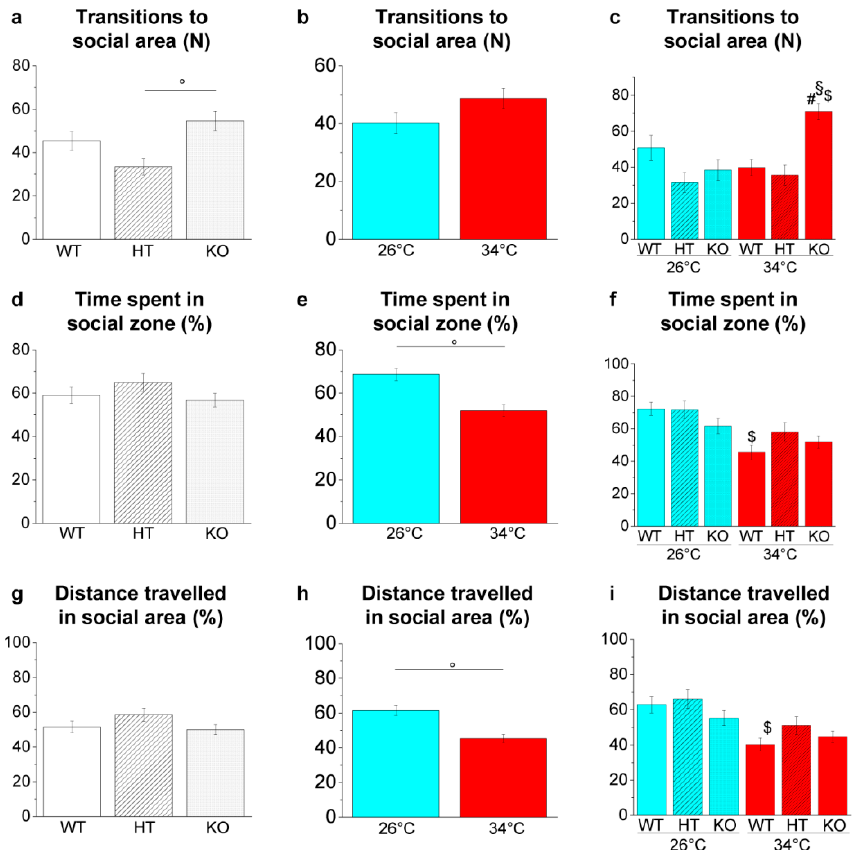
Figure 12. Shoaling behaviour in the SPT. ( a – c ) Number of entries in the social area; ( d – f ) time spent in the social area expressed as percentage of total time; ( g – i ) total distance travelled in the social area expressed as percentage of total time. The data are expressed as mean ± S.E.M. and analysed by two-way ANOVA with Bonferroni post hoc correction. p ≤ 0.05, °; #, HT34 vs. WT34 or KO34 vs. WT34; §, KO34 vs. HT34; $, WT34 vs. WT26, HT34 vs. HT26 or KO34 vs. KO26. p values and symbols used in the figure are shown in Table S25. N = 20. Blue and red colours refer to 26 °C and 34 °C, respectively.